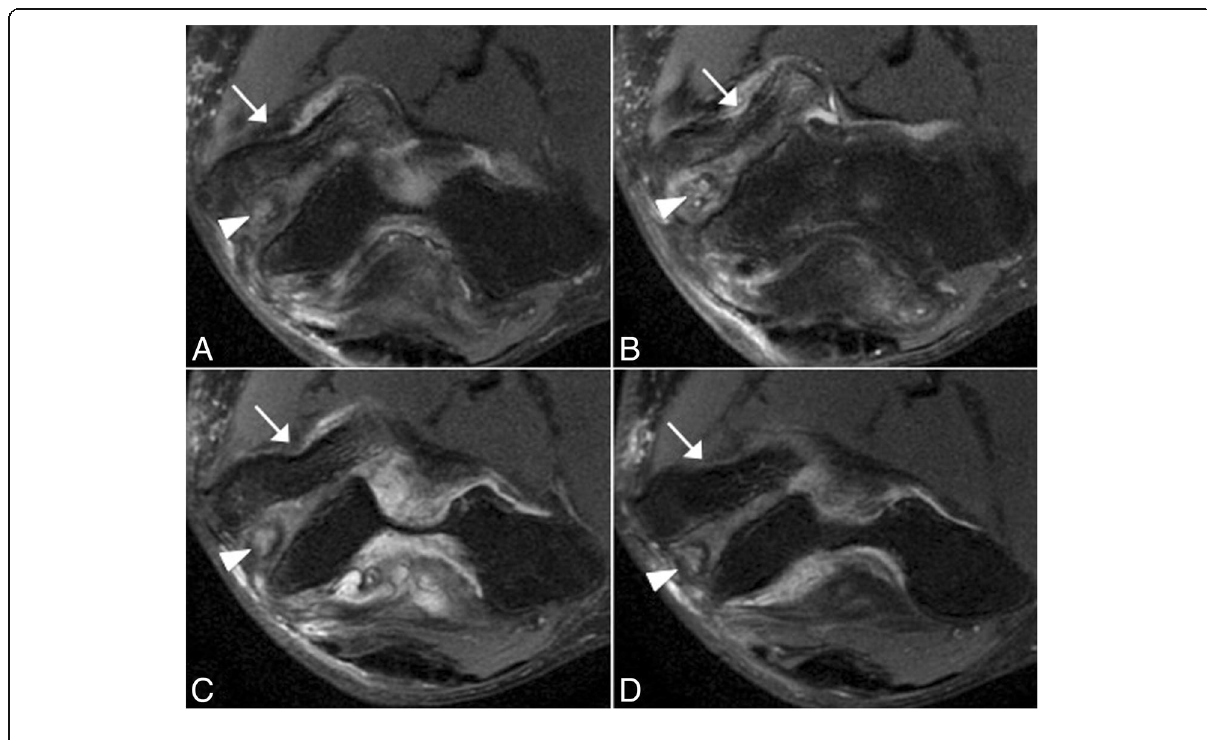
Fig. 16 A 45-year-old woman with pain, muscle weakness, and paresthesias after a fall on an outstretched hand. Consecutive axial FS PD- weighted MRI ( a – d ) showing acute avulsion fracture of the medial epicondyle (white arrows). The ulnar nerve is trapped between osseous fragments (white arrowheads), showing intraneural increased signal intensity